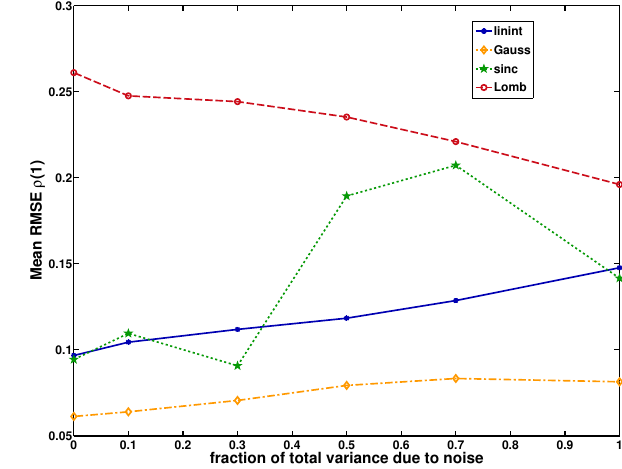
Fig. 10. Effect of the Signal-to-Noise ratio on the RMSE of the ACF for skewed (sk=2) inter-observation times. The share of the noise variance in the overall process variance increases from left to right (cf. Eq.